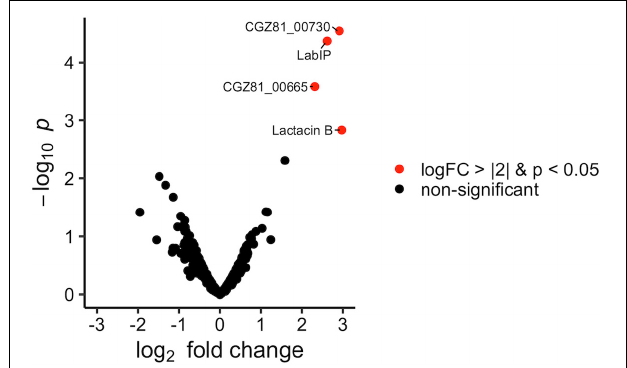
FIGURE 2 | Protein enrichment within LabIP-induced MVs. Volcano plot of assigned MS spectra where each dot represents an identified protein. Fold change was calculated from average spectrum counts of LabIP-induced vs. uninduced and significance values were calculated. Red dots represent proteins with p < 0.05 and log2 fold change of < |2|. Black dots correspond to non-significant change between conditions by p- value or fold